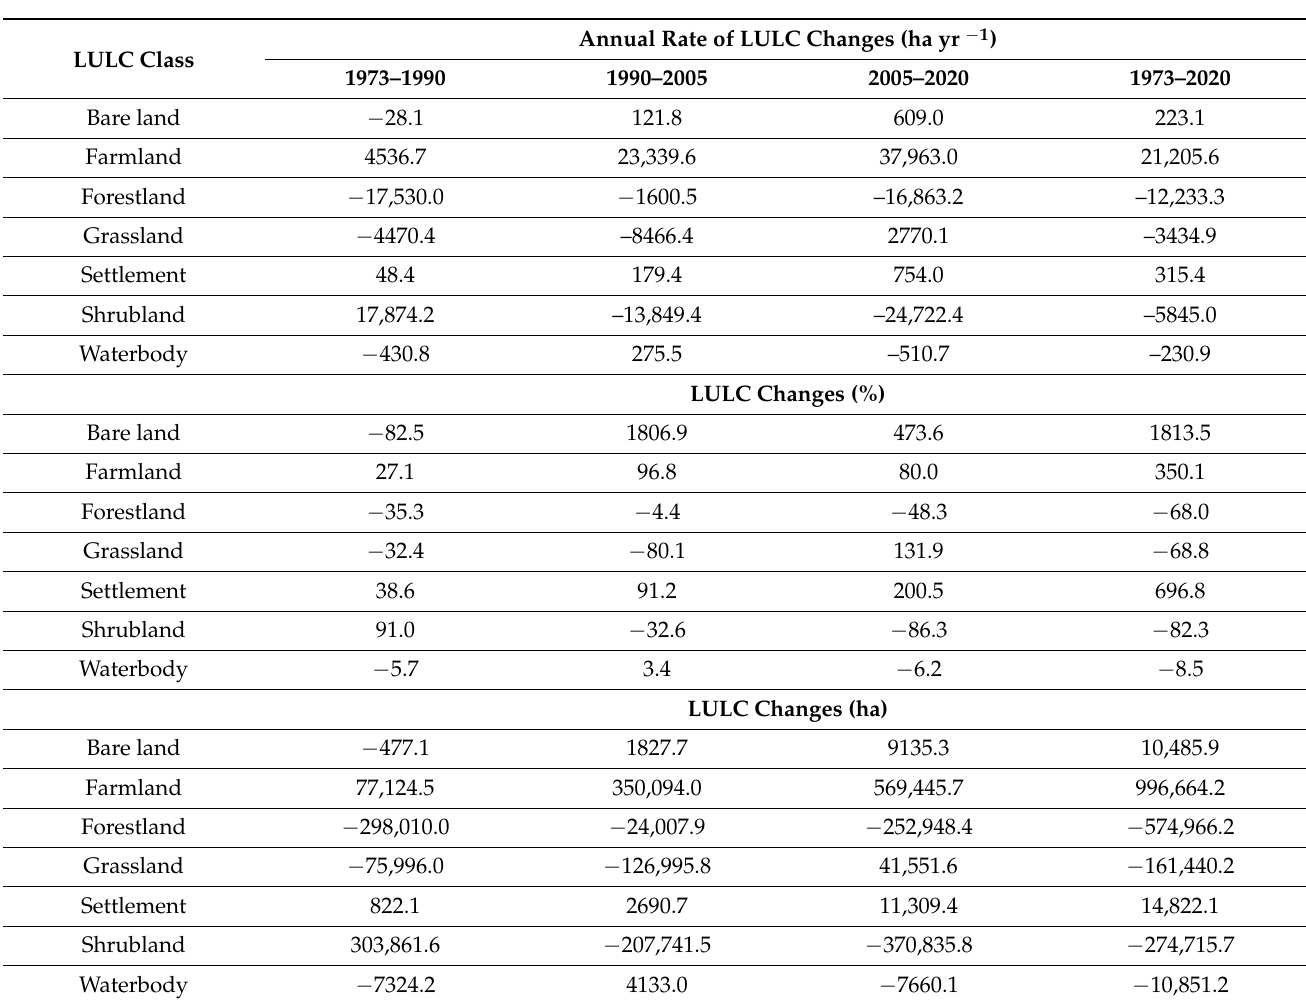
Table 6. Changes in land use and land cover (LULC) from